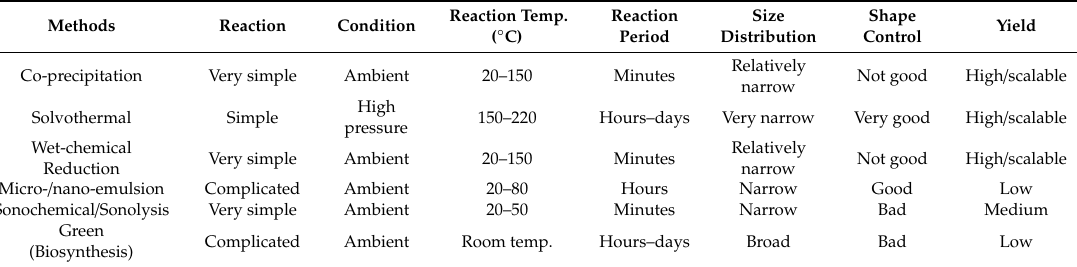
Table 3. Comparison summary of MNP synthesis